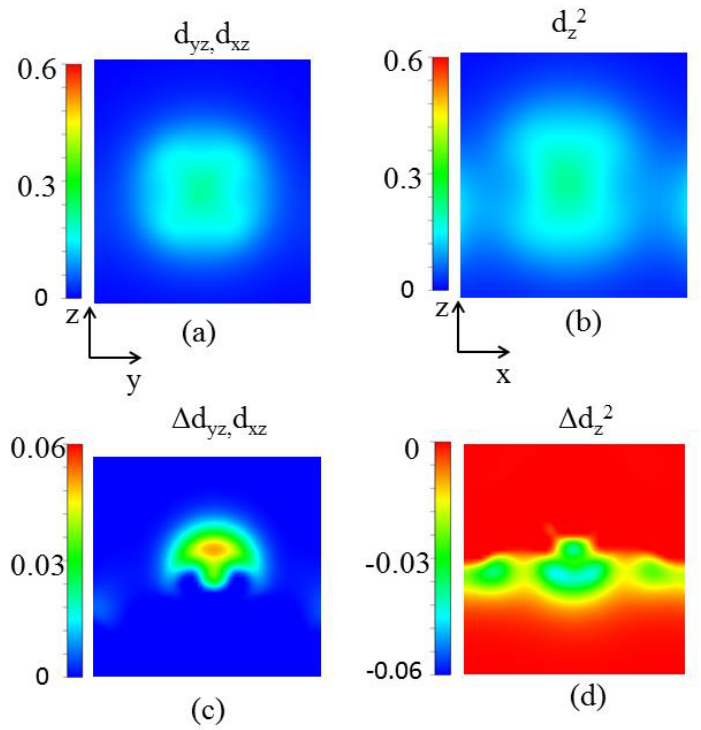
Figure 5. (Color online) ( a , b ) Surface charge densities of d z2 and (d xz ,d yz ) states, respectively, under neutral near the Fermi level. ( c , d ) Charge density differences induced by removing 0.2e per unit cell ( ∆ρ = ρ(0.2e) − ρ(0e) ) . The unit of contour values is e / Å 3 .